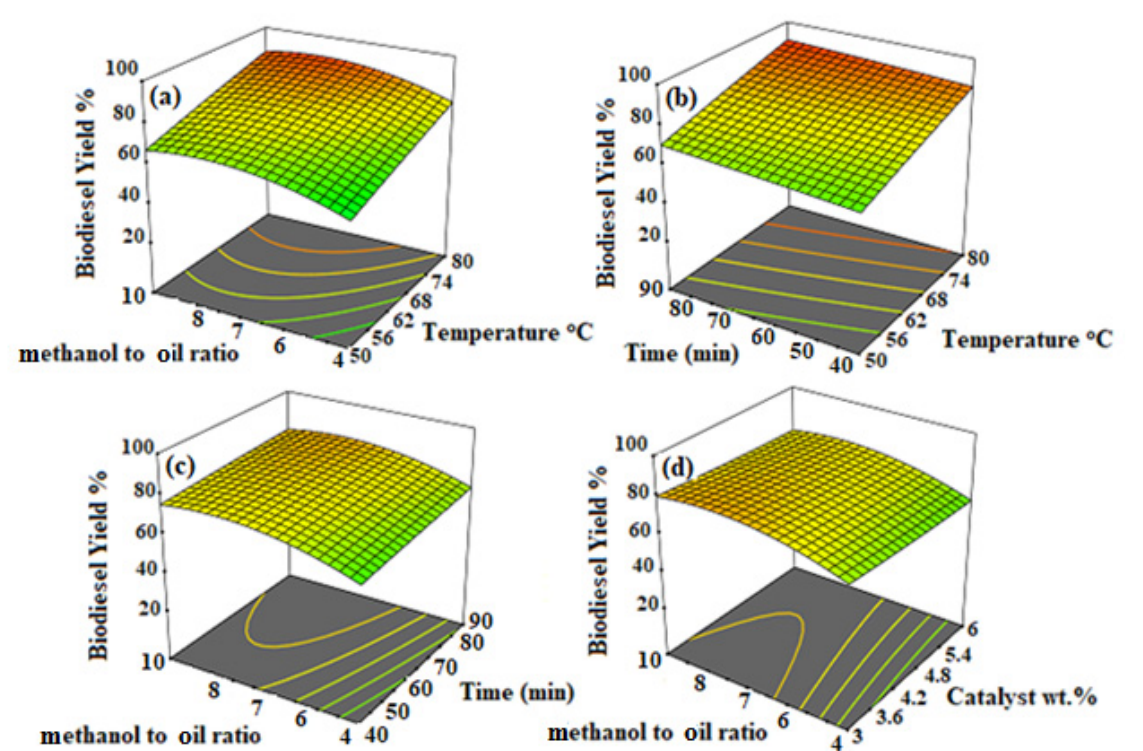
Figure 6. Process parameters are analysed for the biodiesel yield. ( a ) Effect of the process temperature and methanol-to-oil ratio on the biodiesel yield, ( b ) effect of the process temperature and time on the biodiesel yield, ( c ) effect of the process time and methanol-to-oil ratio on the biodiesel yield and ( d ) effect of the process catalyst loading and methanol-to-oil ratio on the biodiesel yield.